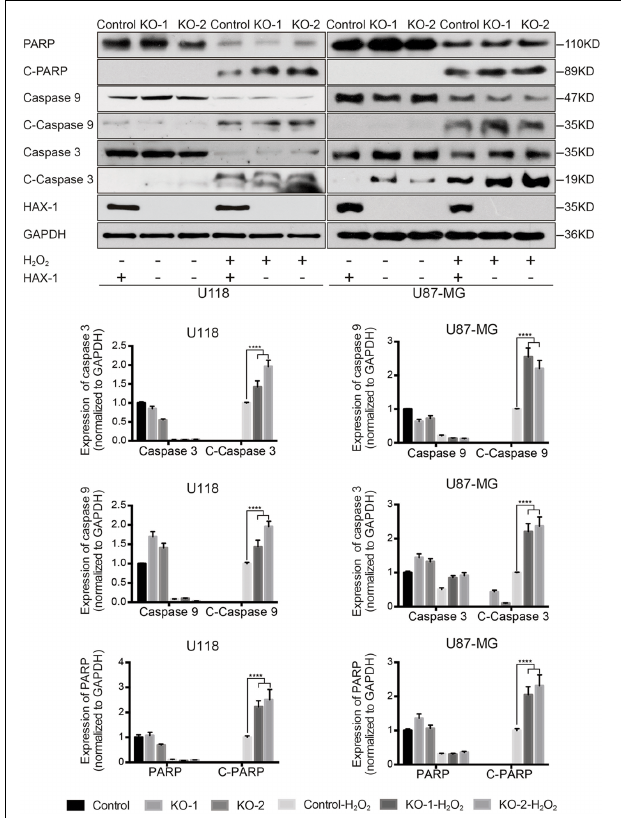
FIGURE 4 | HAX-1 knock-out could increase caspase activation and affect apoptotic protein expression. Western blot indicated the caspase cascade was over-activated in the absence of HAX-1. GAPDH was used as a loading control. Three individual experiments were performed for each group. ∗∗∗∗ P <